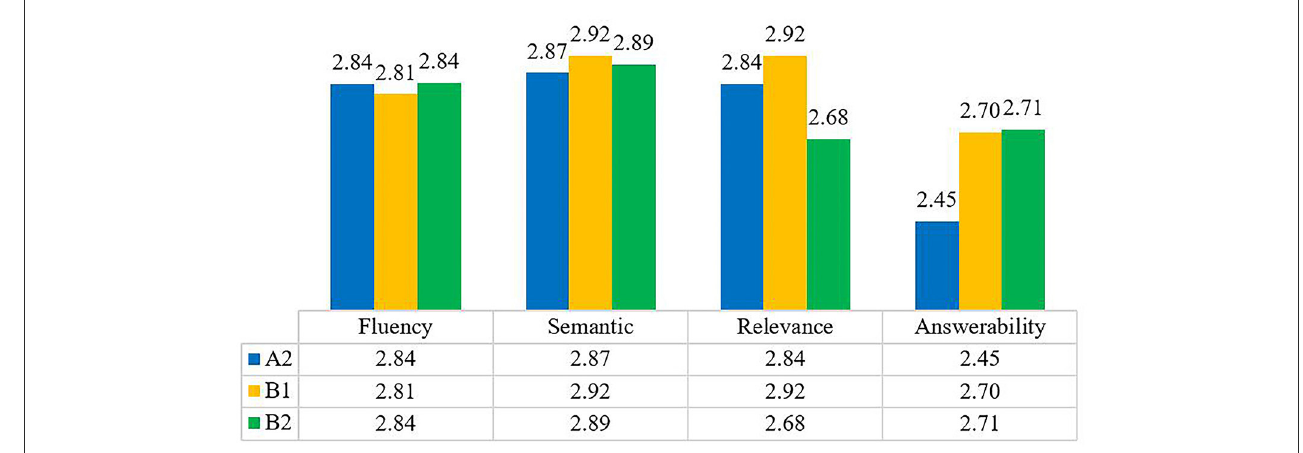
FIGURE8 Question generation evaluation results.